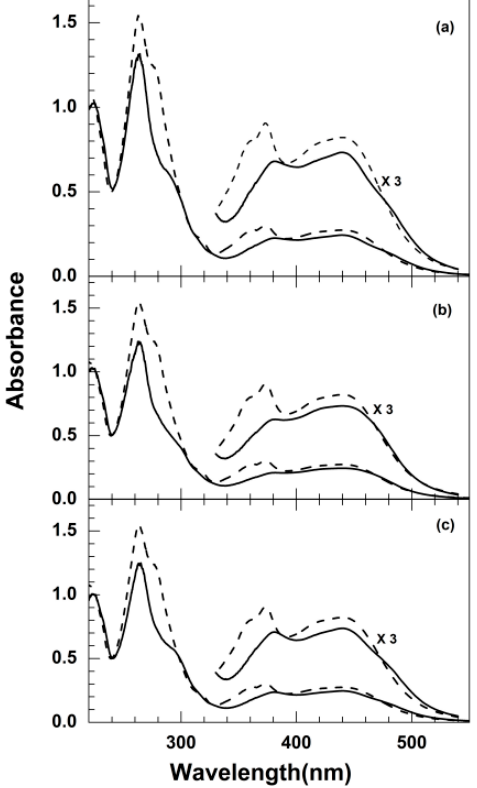
Figure 1. ( a ) Absorption spectra of bis -Ru-bpp bound to poly[d(A-T) 2 ], ( b ) poly[d(G-C) 2 ] and ( c ) poly[d(I-C) 2 ] in the presence (solid curve) and absence (dash curve) of DNA. [DNA] = 100 µ M, [ bis -Ru-bpp] = 10.0 µ M (20.0 µ M in the dppz). The absorption spectra of DNA were subtracted and the spectra enlarged three times are shown at long wavelength for ease of comparison. The absorption spectra of the bis -Ru-bpp bound to DNA at a concentration range below 10.0 µ M were identical for all